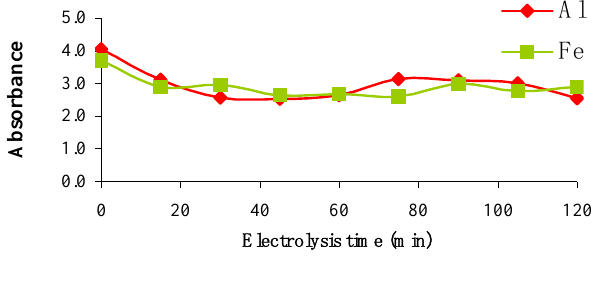
Figure 3. Plots of absorbance at 460 nm and electrolysis time for β -carotene (0.01%) in 27% ethanol; ♦ : with aluminium as electrodes, ■ : with iron as electrodes.